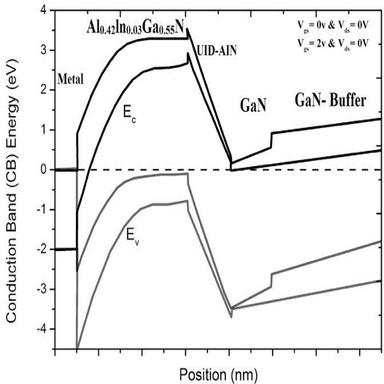
Shows the Energy Conduction band discontinuity diagram at the interface versus position in nm of Al0.42ln0.03Ga0.55N/UID-AIN/GaN/GaN QB-MIS-HEMT observed at the gate voltages (Vgs) of 0 V and 2 V with drain voltage (Vds) of 0 V.